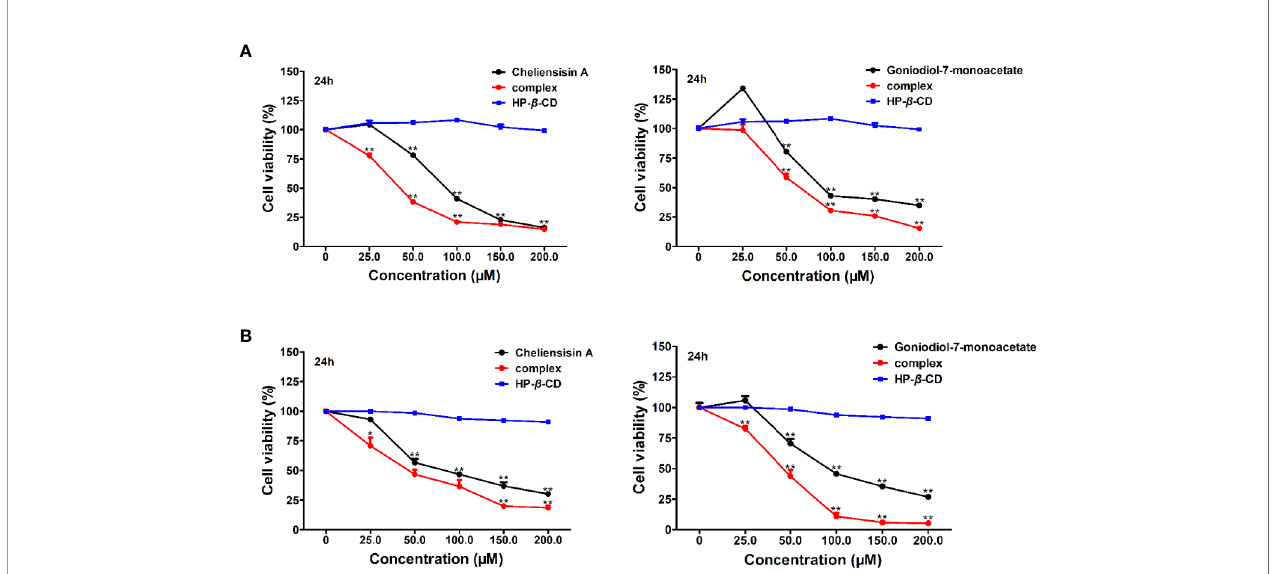
FIGURE 8 | Cytotoxic activity was enhanced by hydroxypropyl- b -cyclodextrin (HP- b -CD) complexes of styryllactones. SMMC-7721 cells (A) and SW1116 cells (B) (5×10 4 cells/ml) were cultured respectively in the absence or presence of various compounds and complexes (25.0, 50.0, 100.0, 150.0, 200.0 m M) for 24 h: cheliensisin A, cheliensisin A/HP- b -CD complex and HP- b -CD; gonidiol-7-monoacetate, goniodiol-7-monoacetate/HP- b -CD complex and HP- b -CD. Data are means ± SEM ( n =3). Results are representative of three separate experiments. *P <0.05, **P <0.01 compared with the group (cell viability in 0 m M).